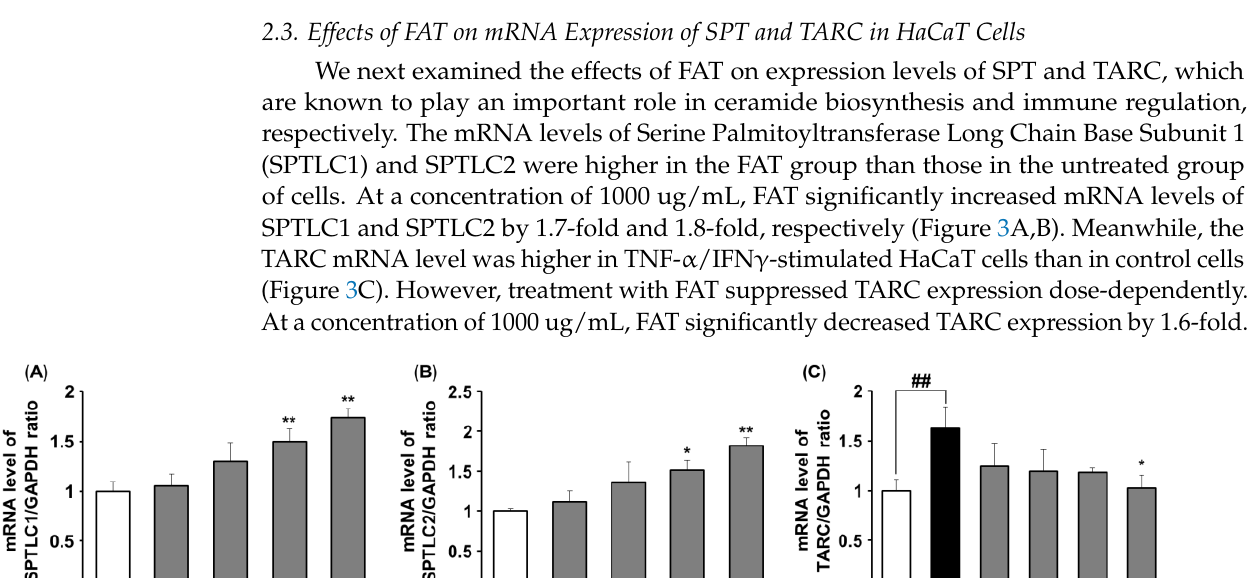
Figure 2. Effects of FAT on the mRNA expression of filaggrin, involucrin, and loricurin in HaCaT cells. ( A ) Filaggrin, ( B ) involucrin, and ( C ) loricurin were determined by RT-PCR. Data represent the mean ± SD of three independent experiments. Statistical significance was assessed by one-way ANOVA followed by Tukey’s test. ** p < 0.01 compared with the untreated cells. FAT; Fermented Angelicae tenussimae with Aspergillus oryzae .